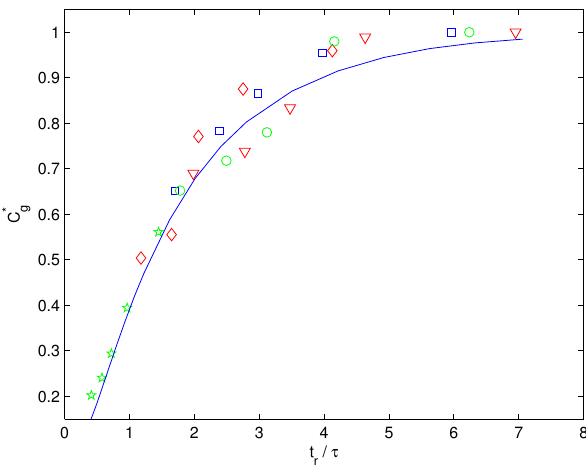
Fig. 5. Dimensionless vapor build up as a function of the equili- bration parameter for the measurements in Figs. 2 and 4. The col- ors/symbols correspond to the same colors/symbols in Figs. 2 and 4. All the simulations in Figs. 2 and 4 collapse on the solid line. C ∗ g =1 corresponds to phase equilibrium at the TD